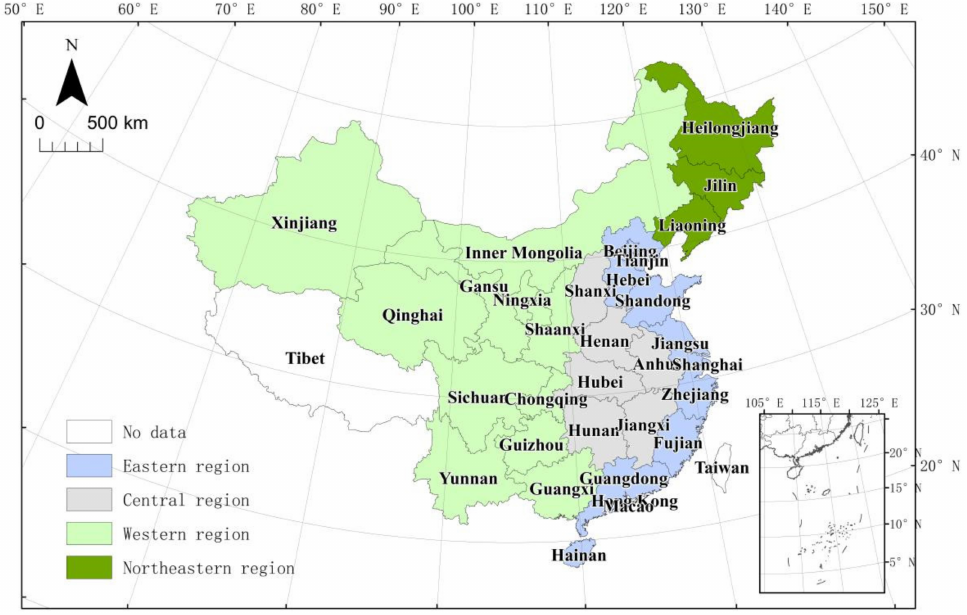
Figure 2. The research areas.